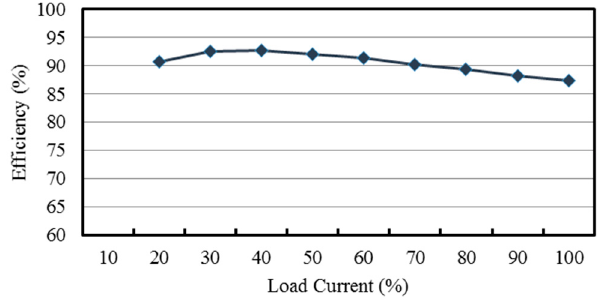
Figure 23. Curve of efficiency versus load current percentage.